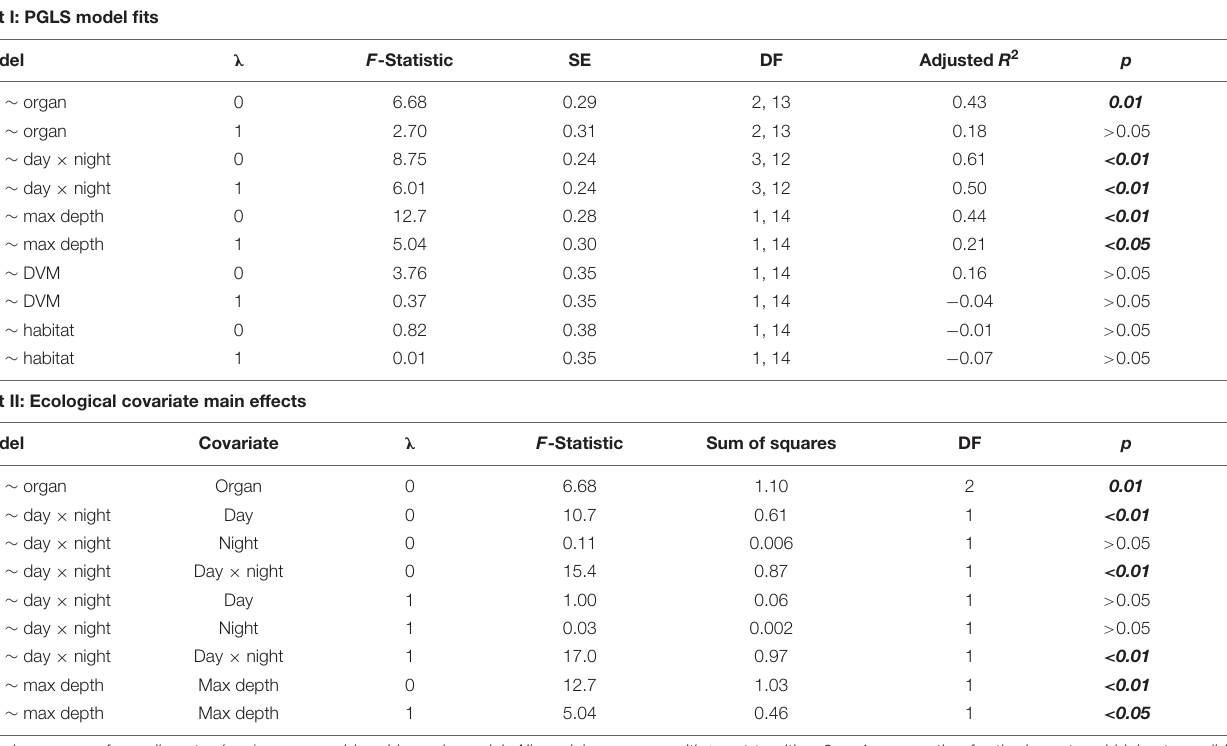
TABLE 4 | Summary of phylogenetic generalized least squares (PGLS) models of absolute eye size in sergestid